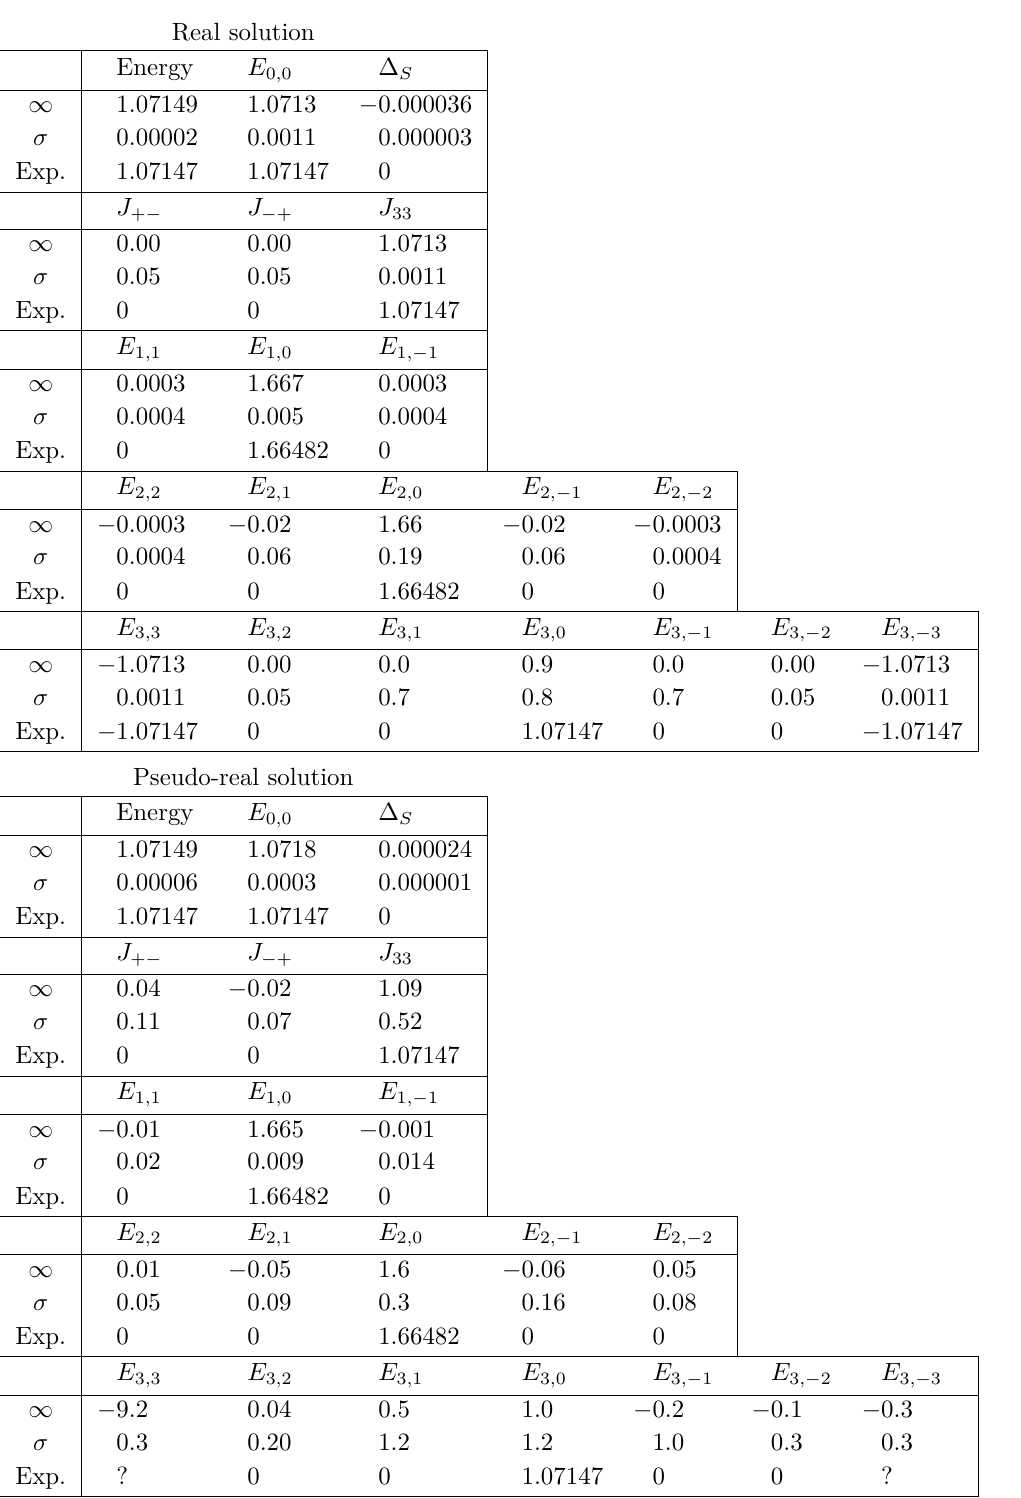
Table 21 . Extrapolations of observables of two B-brane solutions in the k = 6 model with J = 3 boundary conditions. All invariants E